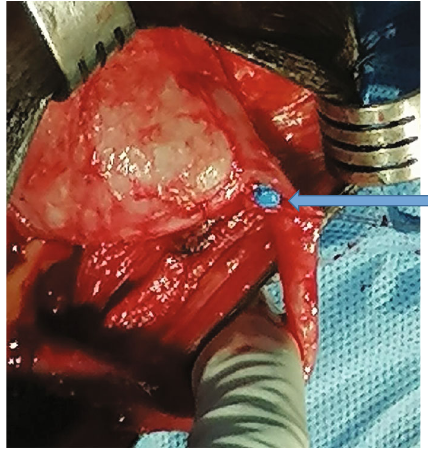
Figure 5: Initial dorsal incision on the catheter tip (arrow) to expose a healthy urethral lumen.